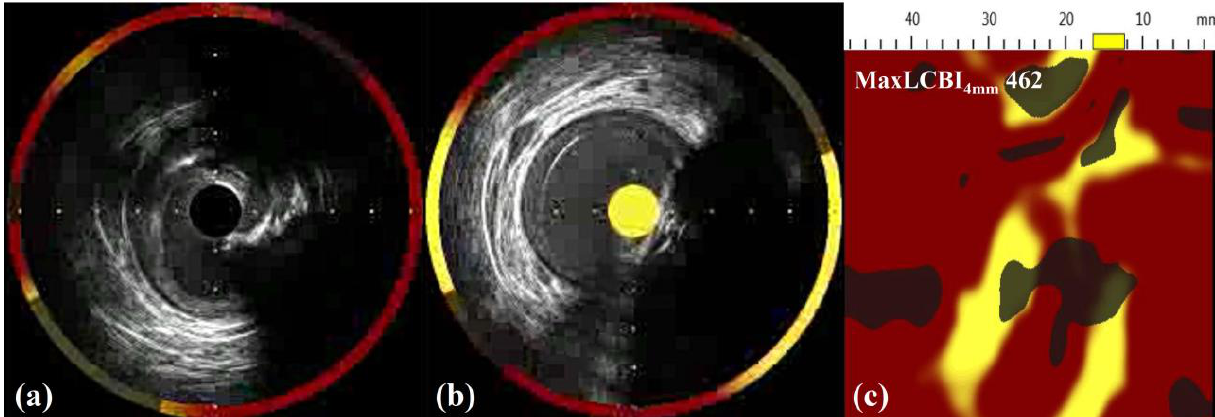
Figure 2. NIRS-IVUS images of the nonobstructive coronary artery lesion. NIRS-IVUS pullback revealing a calcific protrusion in the lesion area ( a ) and high lipid burden ( b ). The LCBI spread-out plot reports a MaxLCBI4mm of 462 ( c ). LCBI, lipid core burden index; MaxLCBI4mm, maximum lipid core burden index at 4 mm; NIRS-IVUS, near-infrared spectroscopy intravascular ultrasound. An EBU 3.5 catheter was engaged, and a Runthrough NS Hypercoat guidewire was